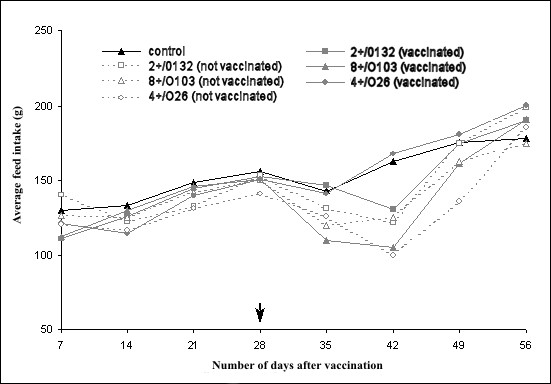
Vaccination experiment followed by challenge with heterologous strains after 28 days. Average feed intake of the different groups of rabbits plotted against day after vaccination. Vaccination with strain 97/246.1Δeae (3-/O15) took place immediately after weaning. All groups, with the exception of the control group, were challenged at day 28 after vaccination (arrow) with a virulent strain of the bio-/serogroup indicated in the legend.